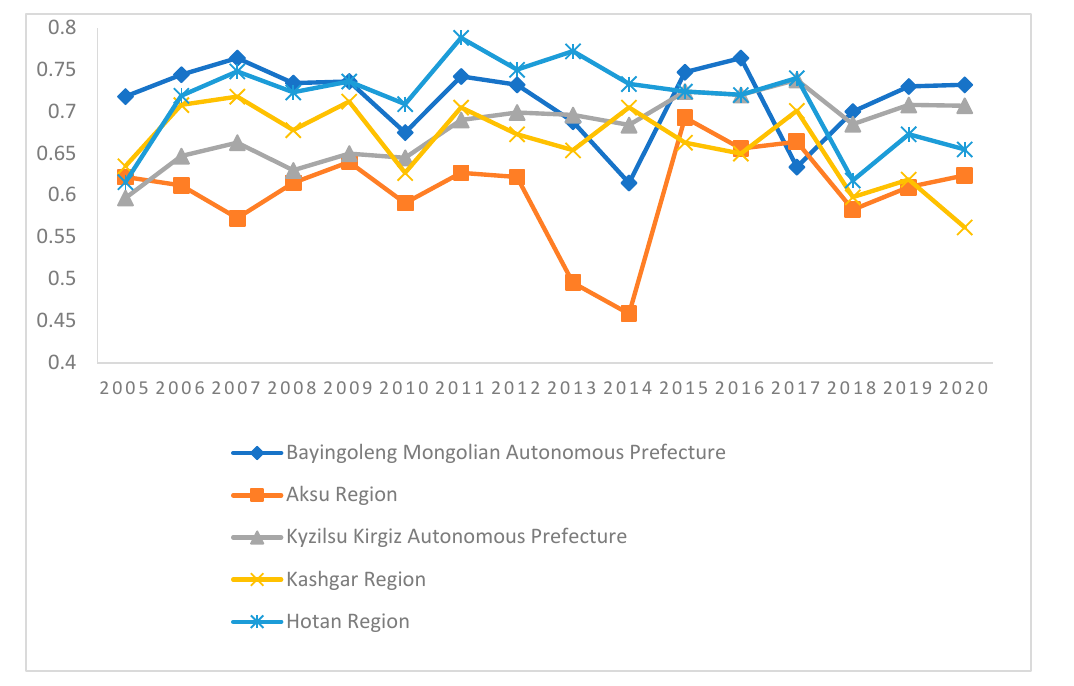
Figure 2. Coupling coordination degree of different regions in Tarim River Basin during 2005–2020.